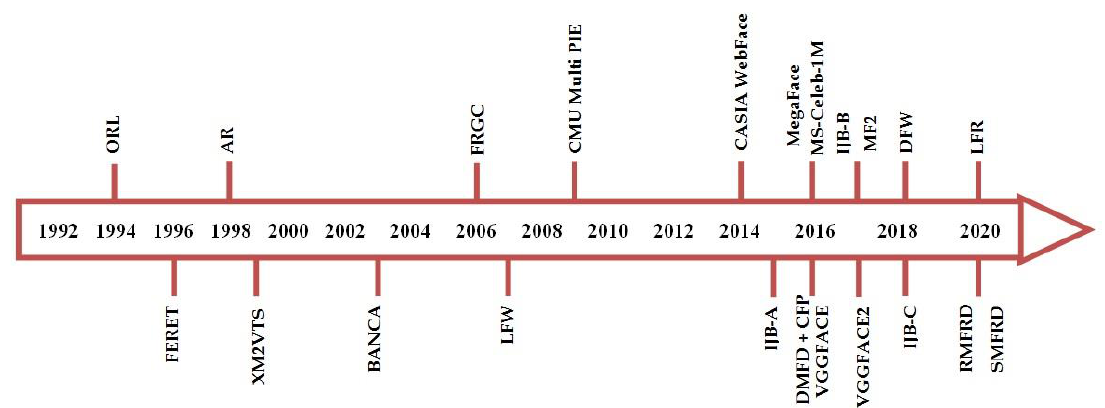
Figure 4. The developments of 2D face recognition datasets through time.